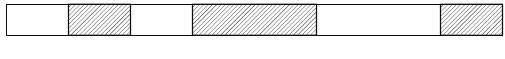
Figure 1: Flexible beam.